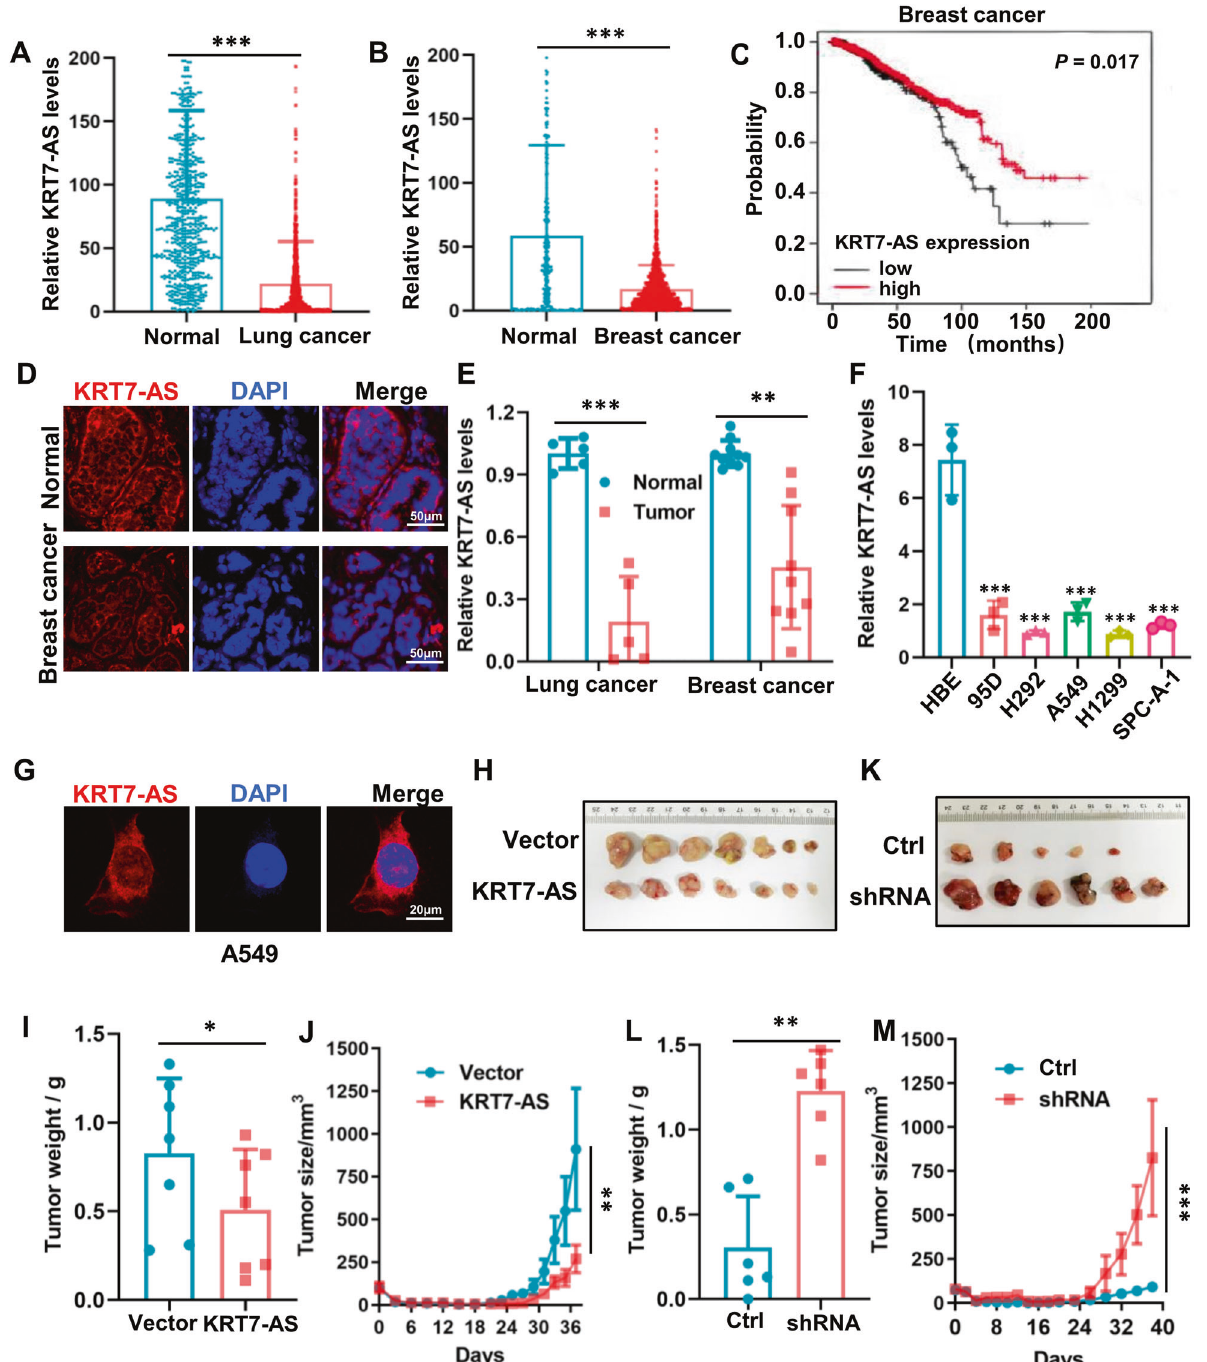
Fig. 1 Expression and tumor-suppressive function of the lncRNA KRT7-AS in lung and breast cancers. The levels of KRT7-AS in lung cancer ( A ), breast cancer ( B ), and the adjacent normal tissues were analyzed by integrative analysis using TCGA database. The in fl uence of KRT7-AS levels on the survival of breast cancer patients was also analyzed using TCGA database ( C ). The expression of KRT7-AS (red) in breast cancer and adjacent normal tissues was examined by FISH ( D ), the nuclei were stained with DAPI (blue). The expression levels of KRT7-AS in paired human breast cancer tissues and lung cancer tissues ( E ), and in lung cancer cell lines (95D, NCI-H292, A549, H1299, SPC-A-1), and in the immortalized normal human bronchial epithelial cell line HBE were analyzed by real time qPCR ( F ). The sub-cellular localization of KRT7-AS (red) was examined by FISH ( G ), the nuclei were stained with DAPI (blue). The inhibitory effect of KRT7-AS on tumorigenesis was accessed in xenograft mice ( H – J , n = 7). Additionally, the tumor size ( J ) and weight ( I ) of xenograft mice were measured and statistically analyzed, and silencing of KRT7-AS strongly enhanced tumor growth in xenograft mice ( K – M , n = 6). The tumor volume was also quanti fi ed using GraphPad ( M ). Above data are shown as mean ± SD of three independent replicates. * P < 0.05, ** P < 0.01, *** P < 0.001.